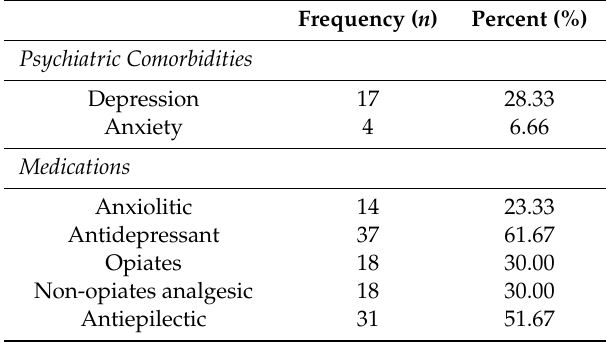
Table 4. Psychiatric comorbidities and medication intake in CP